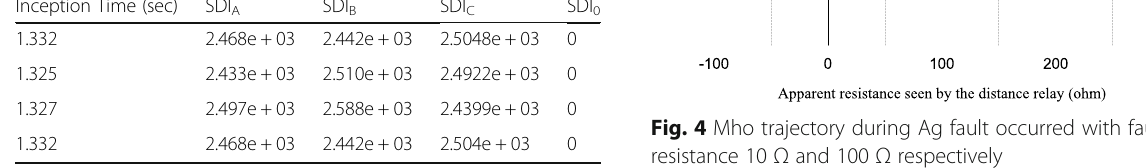
Table 3 SDI values during ABC occurred at different FIT Inception Time (sec)